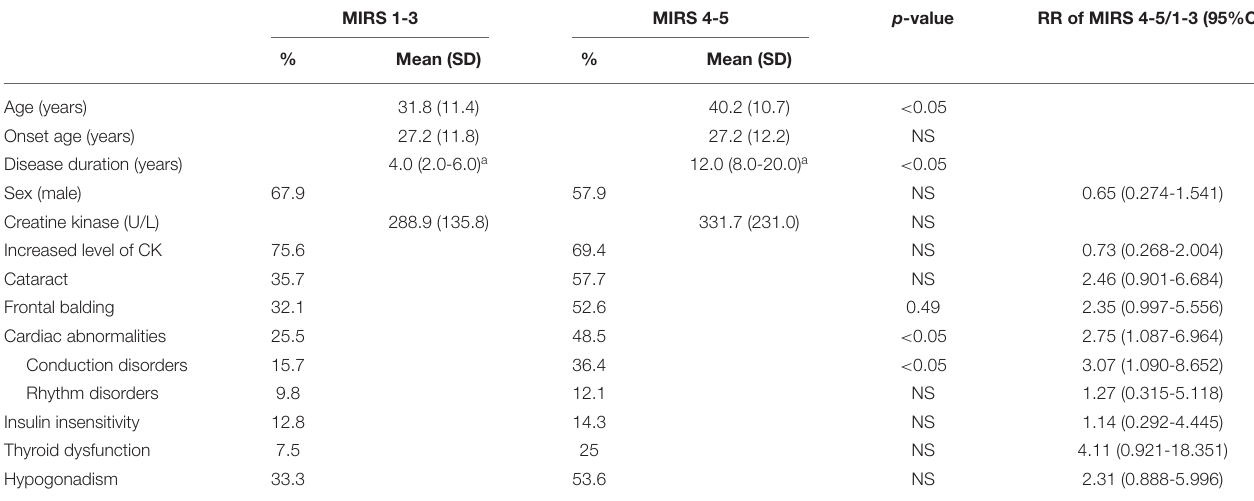
TABLE 2 | Summary of clinical data in DM1 patients divided by severity of muscular